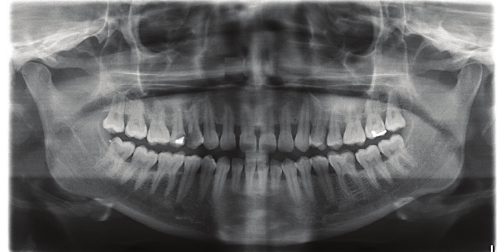
Figure 1: OPG showing three rooted bilateral first premolar; mesiodistal root diameter was greater than the mesiodistal width of the crown.